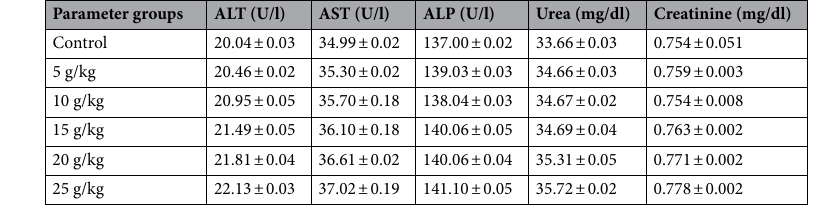
Table 5. Liver and kidney function tests of rats feed on tannyl penta stearate at different concentrations. Data are expressed as mean ± SD values given represent means of three determinations.